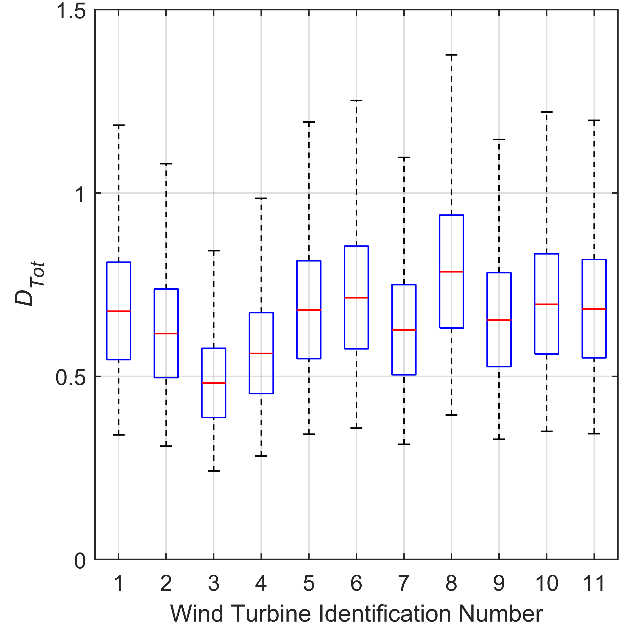
Figure 14. Boxplot of WTB damage D Tot for 11 WT within a same park after a 10-year period. Then, once this model is calibrated, more specific results could be extracted. As an example, taking WT n ◦ 8 mentioned above, the D Tot profiles could be computed (see Figure 15). Take note that the oscillation of D Tot is due the season impact, the distribution of the wind flow parameters changing depending on the season.